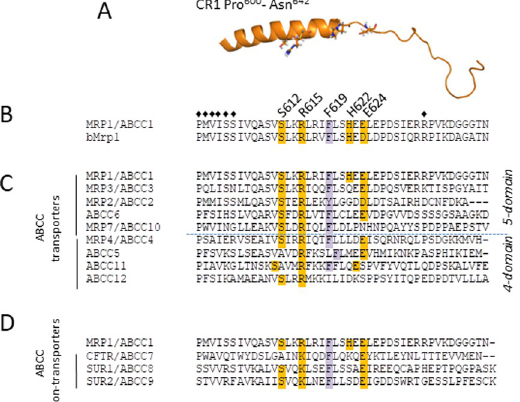
Fig 2. Predicted location and sequence alignments of targeted CR1-MRP1 residues. (A) Shown is a cartoon of the secondary structure of MRP1-CR1 (amino acids 600–642) obtained from the atomic homology model of human MRP1 based on the cryo-EM structure of apo bovine Mrp1 (PDB: 5UJ9) [43]. The side chains of the initial four targeted CR1 residues [Ser 612 , Arg 615 , His 622 , Glu 624 ] are shown in stick form and coloured by element where oxygen is red and nitrogen is blue . Sequence alignments of human MRP1-CR1 with (B) bovine Mrp1; (C) human ABCC 5-domain and 4-domain transporter homologs; and (D) human ABCC non-transporter homologs were generated using Clustal Omega [60]. The initial four and subsequent single CR1 amino acids targeted for mutagenesis in this study (Ser 612 , Arg 615 , His 622 , Glu 624 , and Phe 619 , respectively) are highlighted in dark orange and purple , respectively. In (B), the diamond symbols ( ♦ ) above the sequence denotes the seven amino acids in this region (and the COOH- proximal end of TM11) investigated previously (Pro 600 , Met 601 , Val 602 , Ile 603 , Ser 604 , Ser 605 , Arg 633 ) [57, 72, 73] (Cole laboratory,